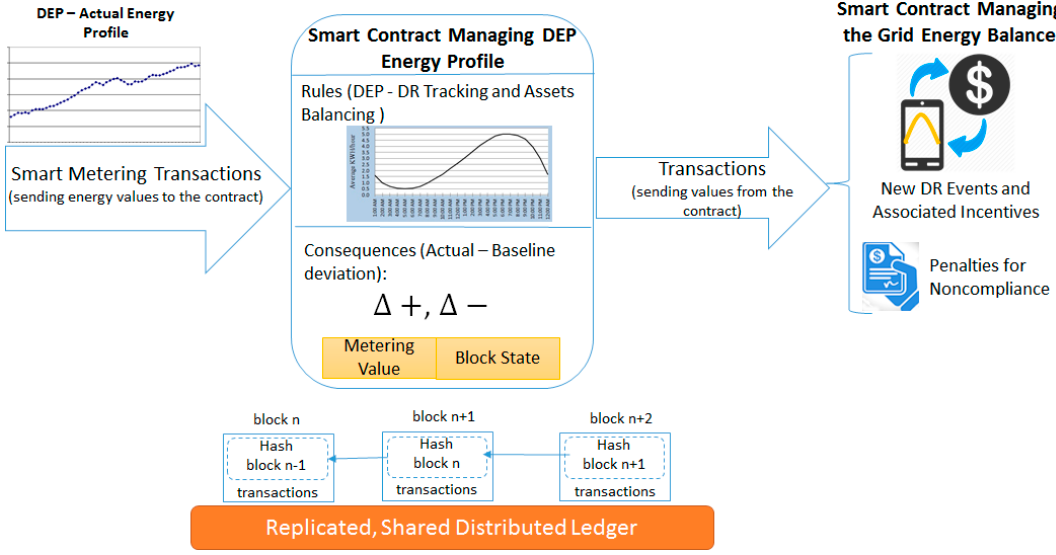
Figure 4. Self-enforcing smart contracts for DR services tracking, energy assets balancing, and decentralized control.